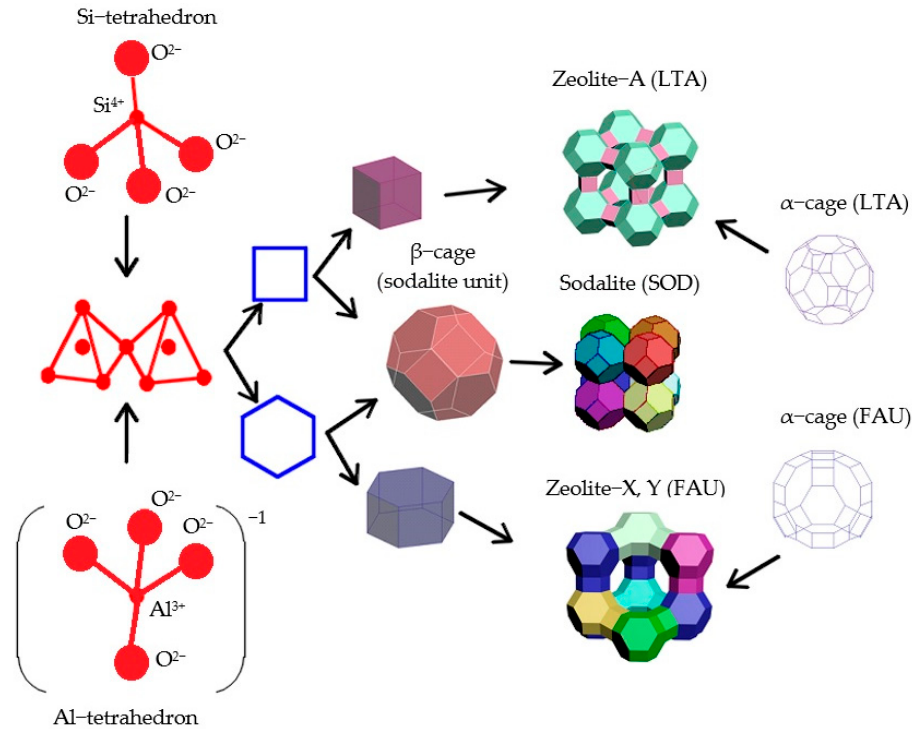
Figure 13. Hierarchical diagram of the shaping of the porous structure of zeolites [compiled by the authors].